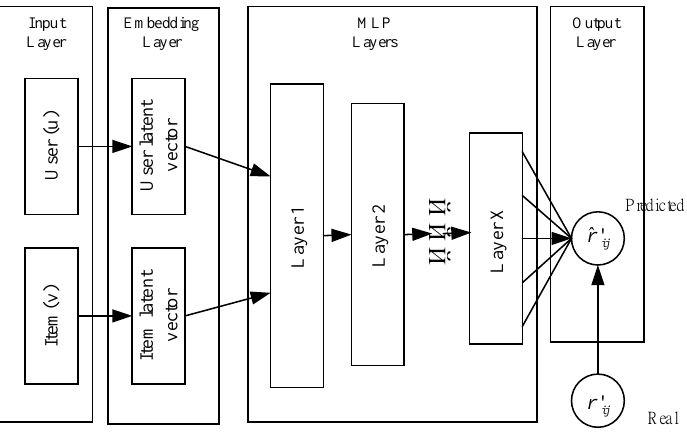
Figure 3. The structure of the NNCF predictor.